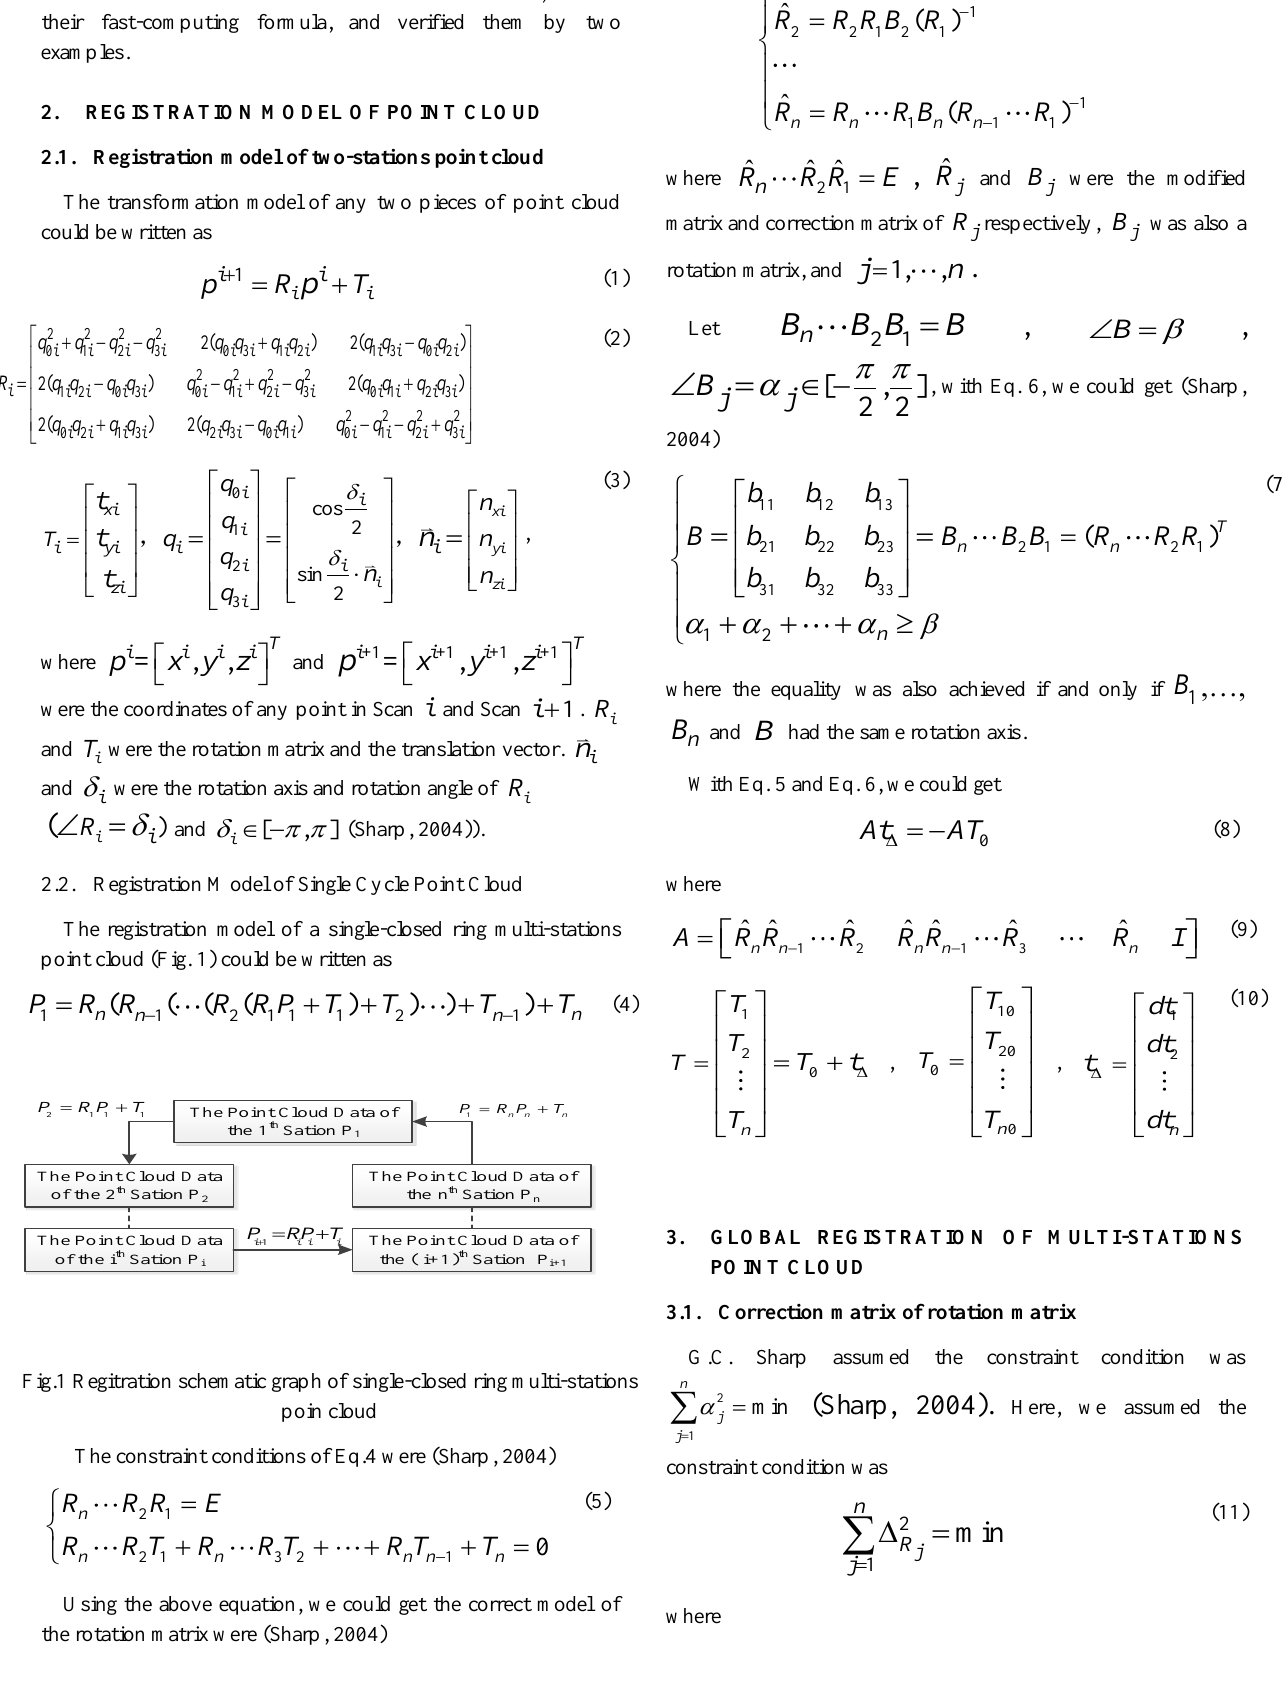
Fig.1 Regitration schematic graph of single-closed ring multi-stations poin